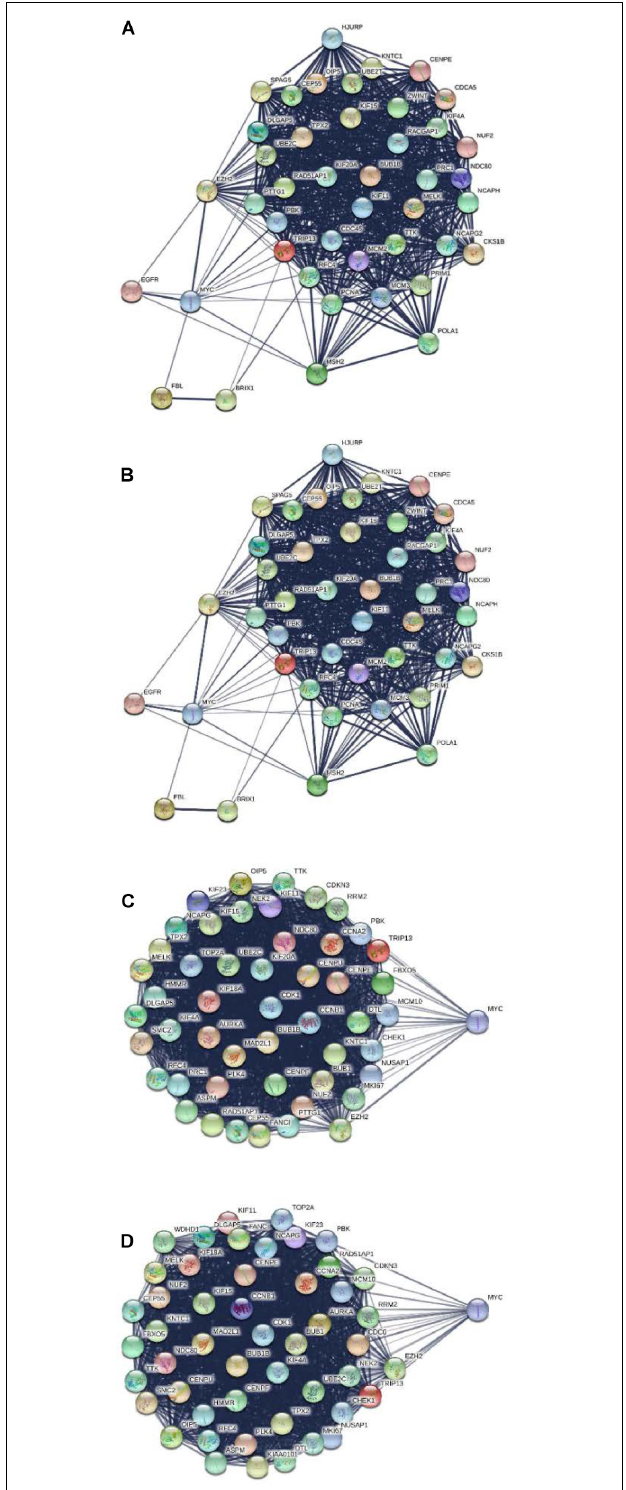
FIGURE 7 | Protein–protein interaction network for MYC in different stages. (A) MYC showed significance in stage I. (B) MYC showed significance in stage II. (C) MYC showed significance in stage III. (D) MYC showed significance in stage